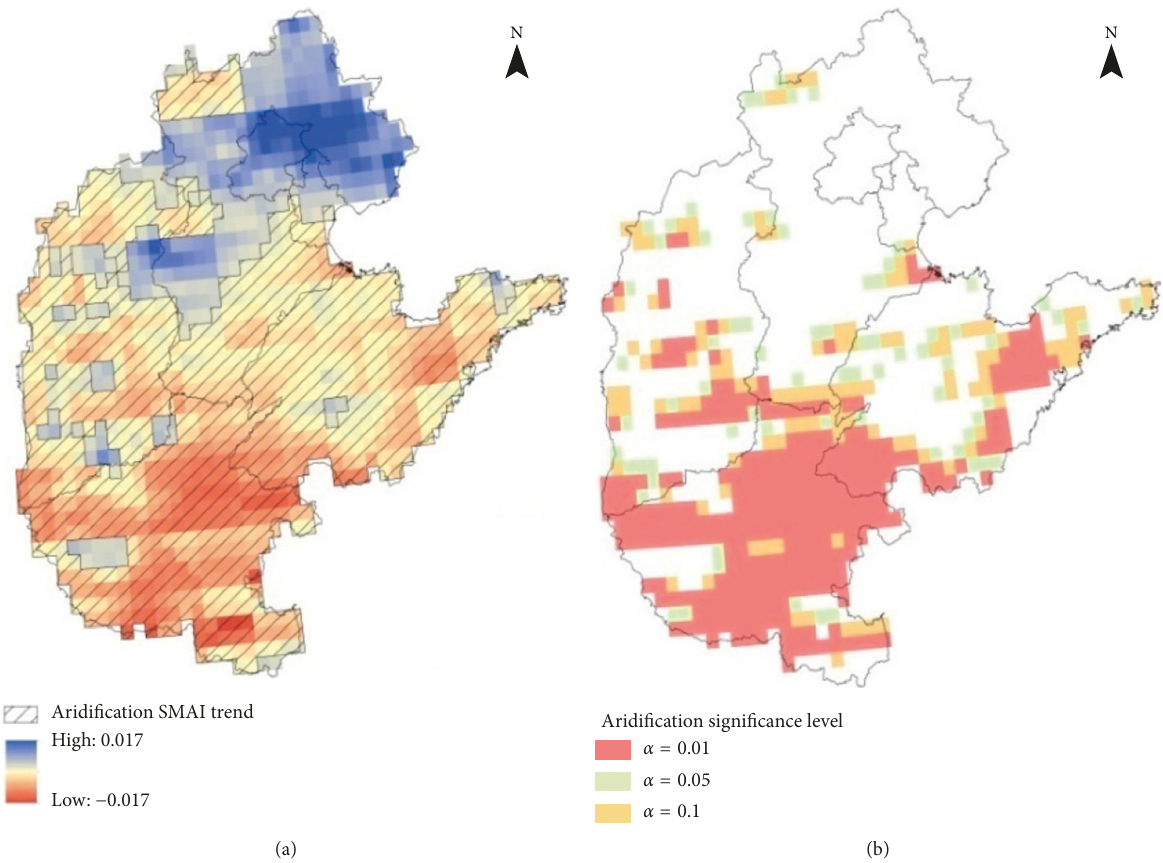
Figure 4: Spatial distribution of monthly SMAI-1 change slope (a) and significance level